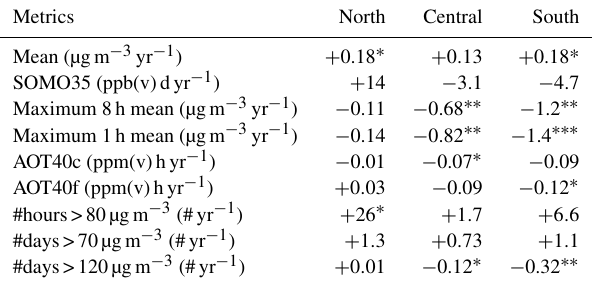
Table 3. Linear trend during 1990–2013 of policy-related metrics in the three Swedish regions north, central and south (see Fig. 3). Asterisks ( ∗ , ∗∗ , and ∗∗∗ ) indicate that the trend is significant ( p ≤ 0 . 05, p ≤ 0 . 01, p ≤ 0 . 001,